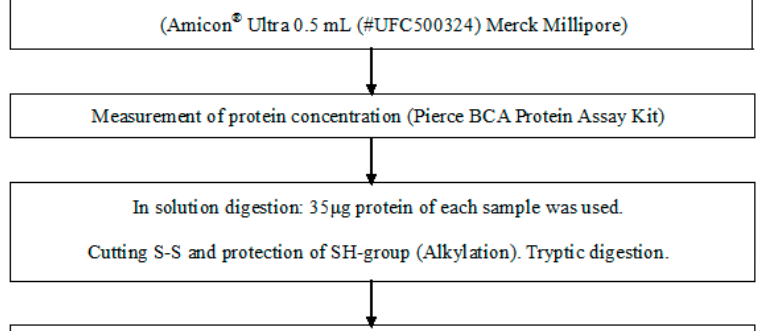
Figure 2. iTRAQ proteomic analysis. iTRAQ: Isobaric Tag for Relative and Absolute Quantitation.